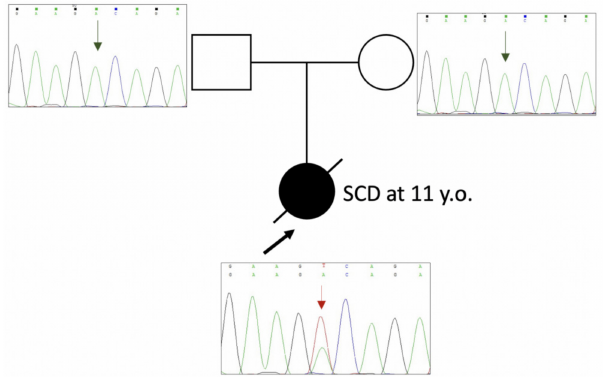
Figure 1. Pedigree of the family SD5. The affected family member is shown with closed and crossed- out symbols, and the unaffected parents with open symbols. Proband is marked by the black arrow. Fragments of the Sanger electropherograms of the TPM1 gene are shown near the symbol of a family member. The letters in the upper row do not designate amino acids but nucleotides (A—adenine, green peaks; C—cytosine, blue peaks; G—guanine, black peaks; and T—thymine, red peaks). The heterozygous mutation c.656A>T (p.D219V) is marked by the red arrow.